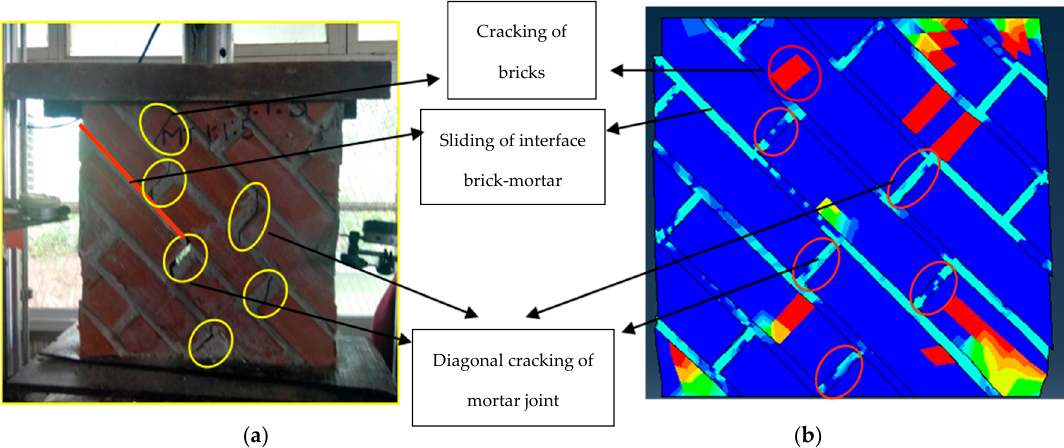
Figure 16. ( a ) Experimental crack pattern; ( b ) numerical crack pattern of unreinforced wall (MTB).